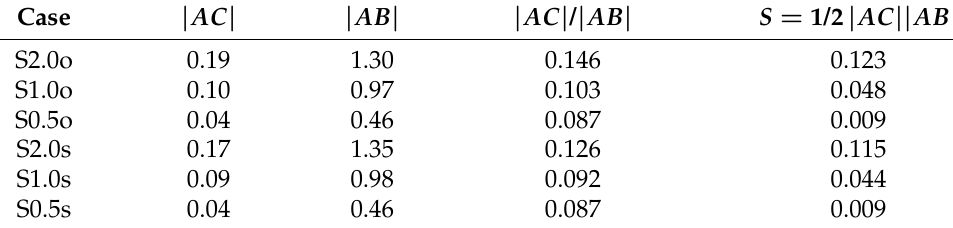
Table 2. Characteristic dimensions of the recirculation zones.